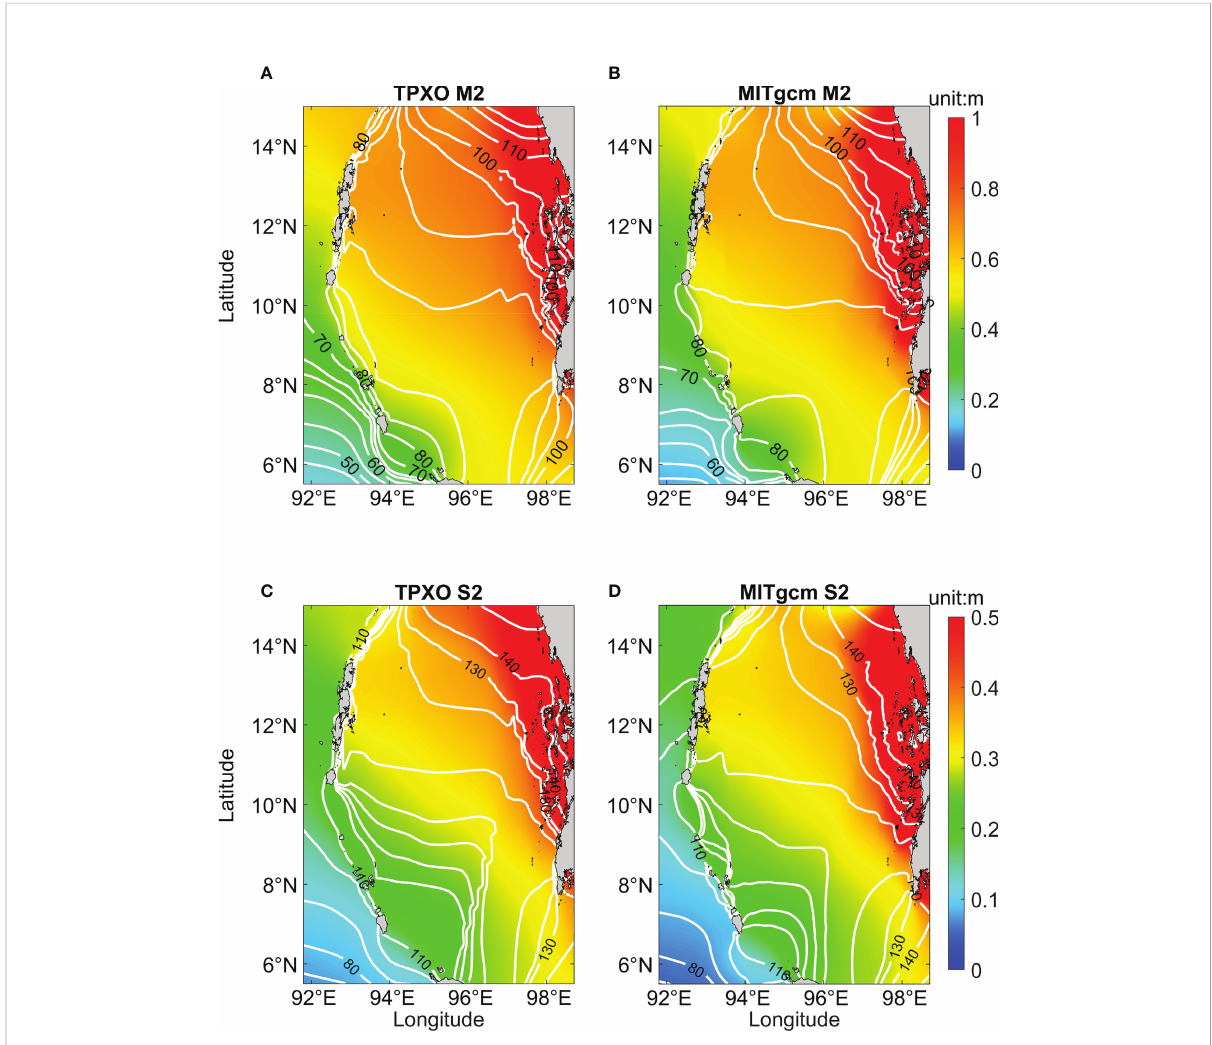
FIGURE 3 M2 and S2 cotidal charts for the barotropic tides based on the (A, C) TPXO and (B, D) simulation results. The colors indicate the amplitude, and the contours represent the phase. The color scale of M2 cotidal chart ranges from 0 to 1 m, and the color scale of S2 cotidal chart ranges from 0 to 0.5 m.